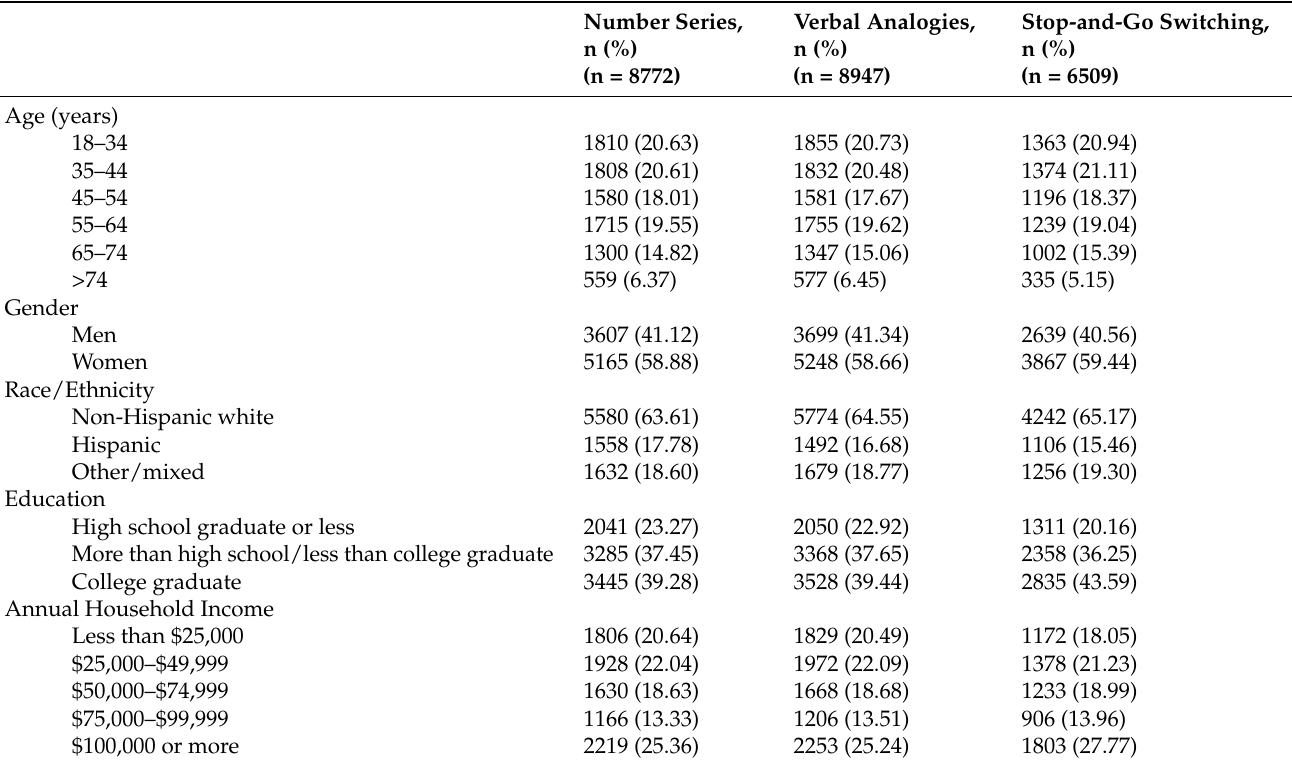
Table 1. Demographic characteristics of the analysis sample for each cognitive